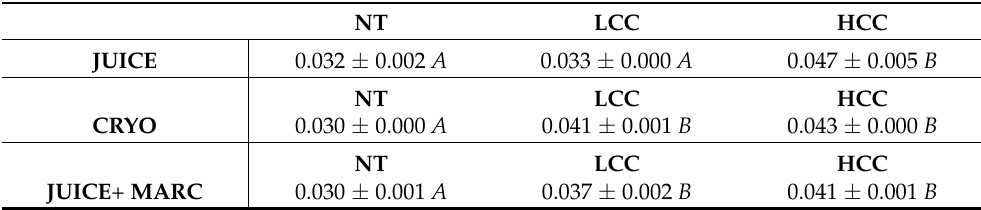
Table 5. Glycerol produced to sugar consumed ratio at the end of fermentations in JUICE, CRYO and JUICE + MARC. NT LCC